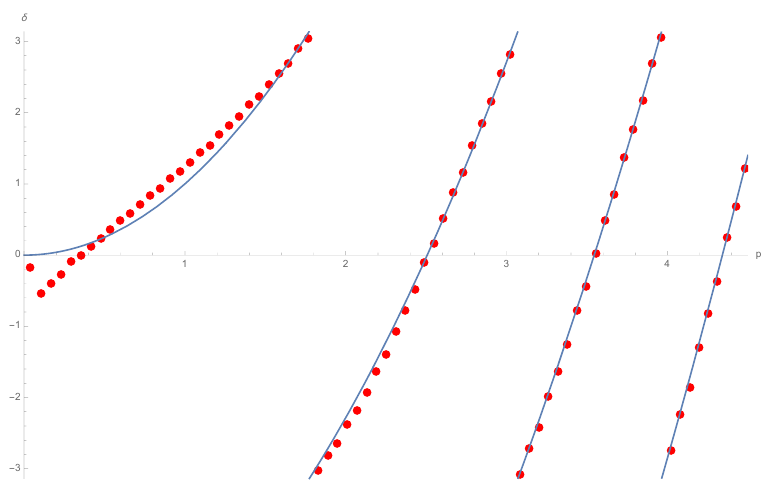
Figure 1. Numerical phase shift corresponding to the Schrödinger equation (2.8) (red points) versus the shock wave phase shift (solid